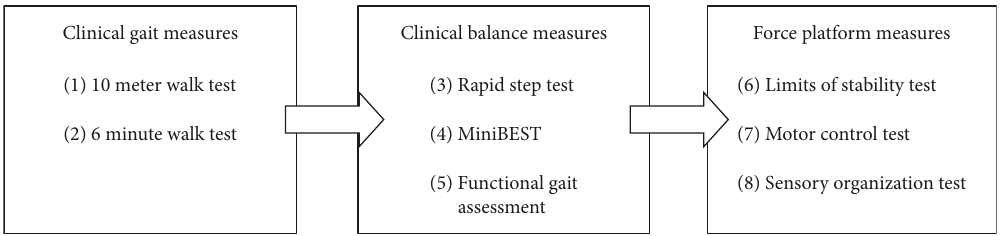
Figure 2: Testing protocol utilized for both Parkinson’s disease and healthy cohorts. Table 3: Descriptive statistics of force platform measures.